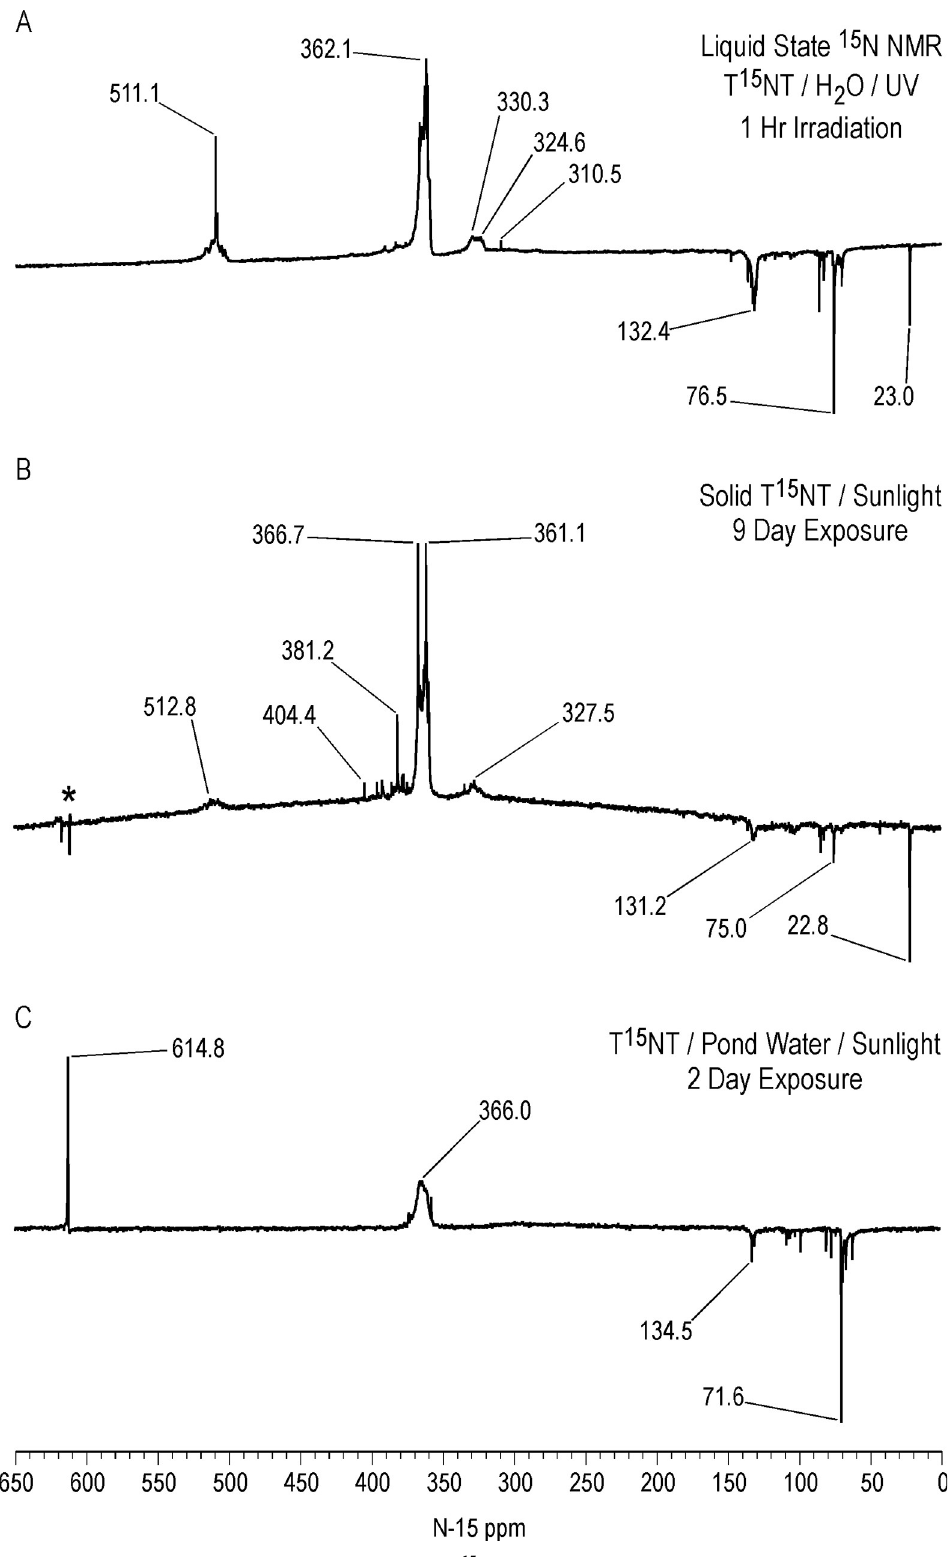
Fig 21. Liquid state ACOUSTIC N-15 NMR spectra of T 15 NT. A. Lamp irradiation in deionized water. B. Sunlight irradiation in the solid state. C. Sunlight irradiation in pond water. Line broadening = 3 Hz. https://doi.org/10.1371/journal.pone.0224112.g021 PLOS ONE | https://doi.org/10.1371/journal.pone.0224112 October 22,